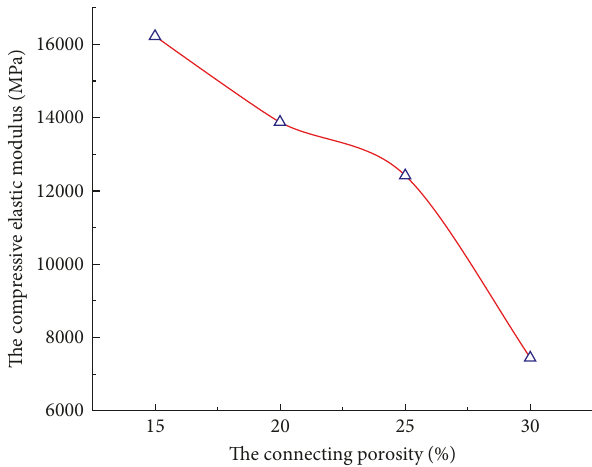
Figure 19: Relationship between connected porosity and com- pressive elastic